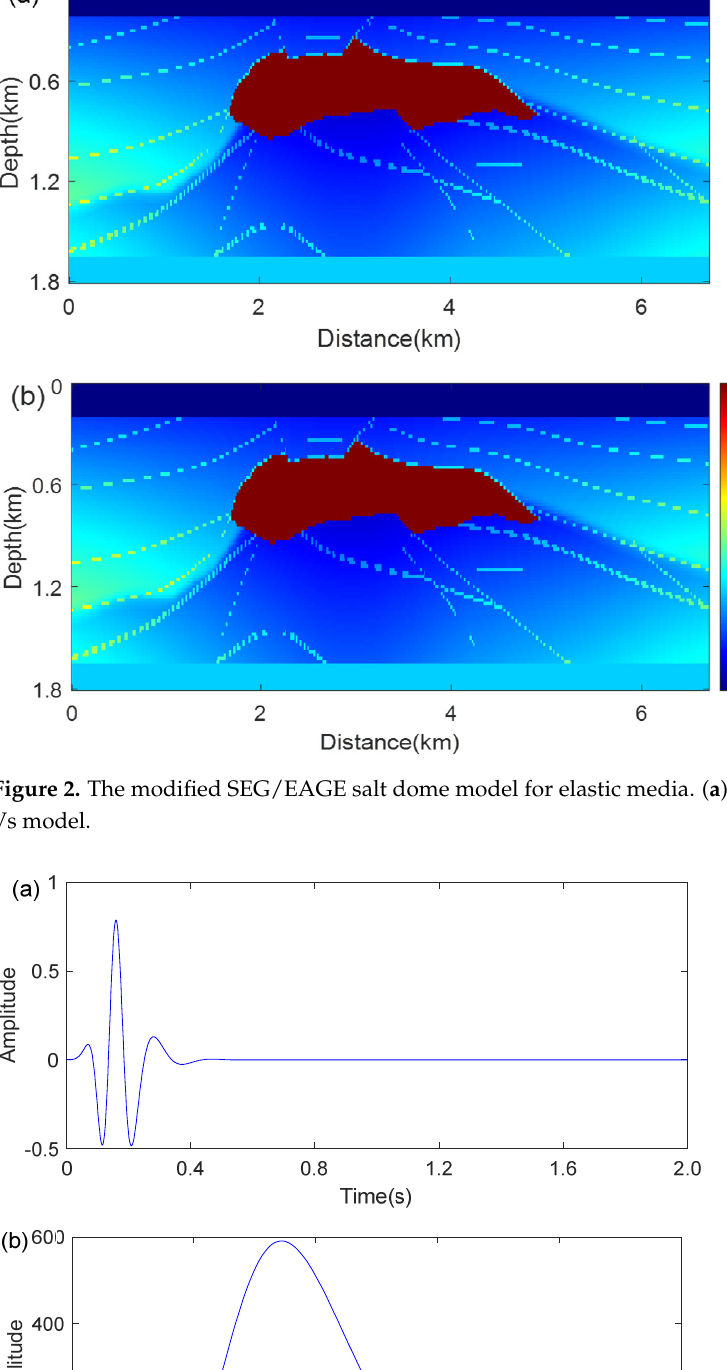
Figure 3. Source wavelet and its spectrum. ( a ) Waveform of source wavelet; ( b ) Spectrum of source wavelet.